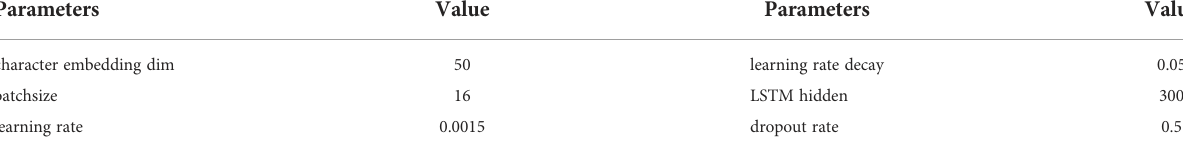
TABLE 2 Hyper-parameter value.